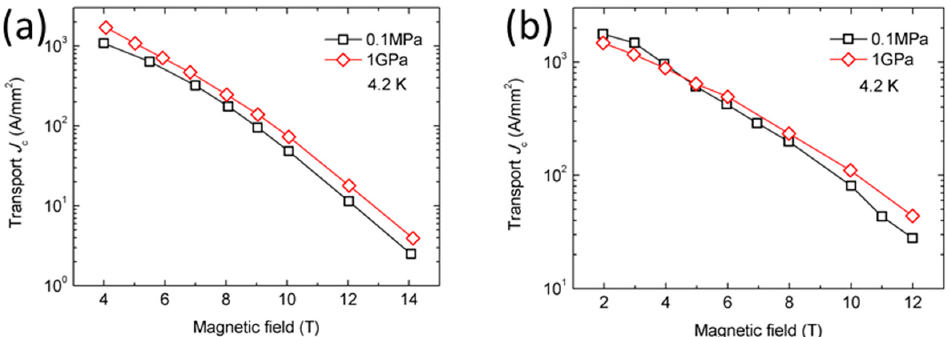
Figure 6. Comparison of SEM micrographs of ( a ) a normal-pressure filament and ( b ) an HIP filament [40]. Adapted with permission from Ref. [40]. 2014, IOP Publishing.